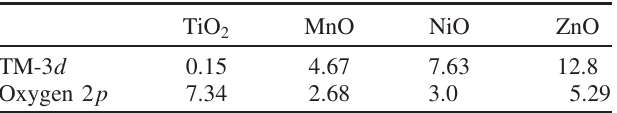
TABLE I. Converged values of the effective on-site Coulomb parameter U (in eV) for the transition metal (TM) 3 d and the oxygen 2 p